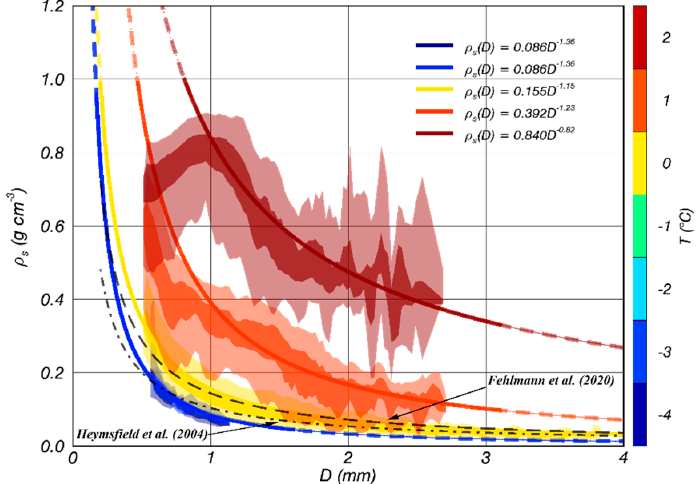
Figure 6. Color − shaded 2D histogram plots of ρ s versus D for each T class. The color shades correspond to the data range of ±10% and ±25% from the median value. The black long − and dot − dashed lines denote the relationships of ρ s versus D for dry snow, as suggested in [48,50],